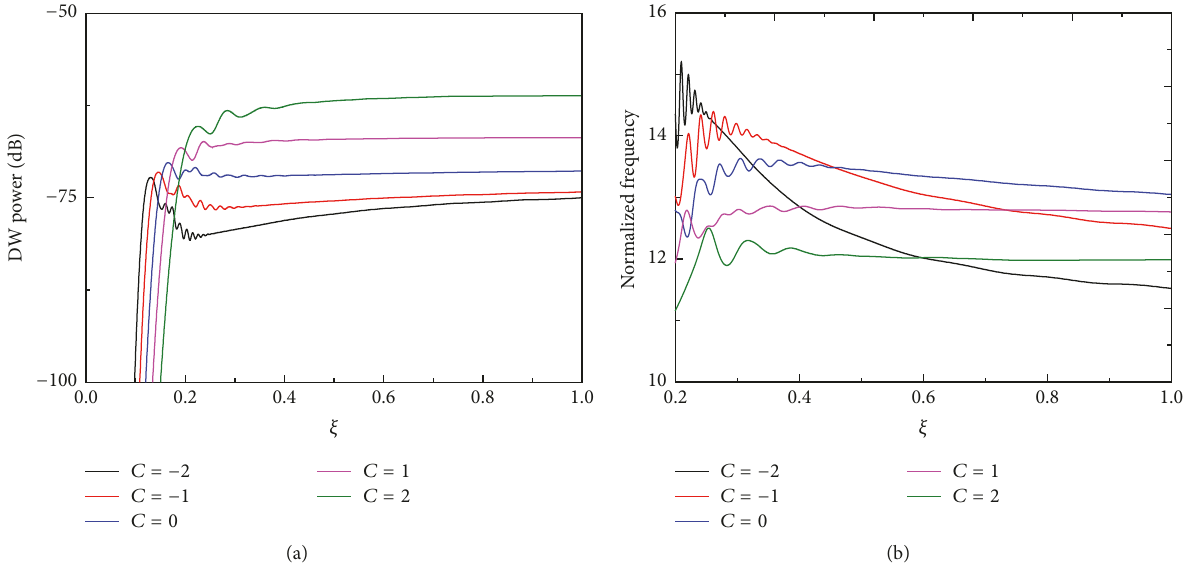
Figure 8: Evolution of the blue-shift DW of central frequency (a) and relative average intensity (b) along the propagation distance, with different chirp but the sign of TOD is negative: dark solid curves 𝐶 = −2 ; red solid curves 𝐶 = −1 ; blue solid curves 𝐶 = 0 ; magenta solid curves 𝐶 = 1 ; olive solid curves 𝐶 = 2